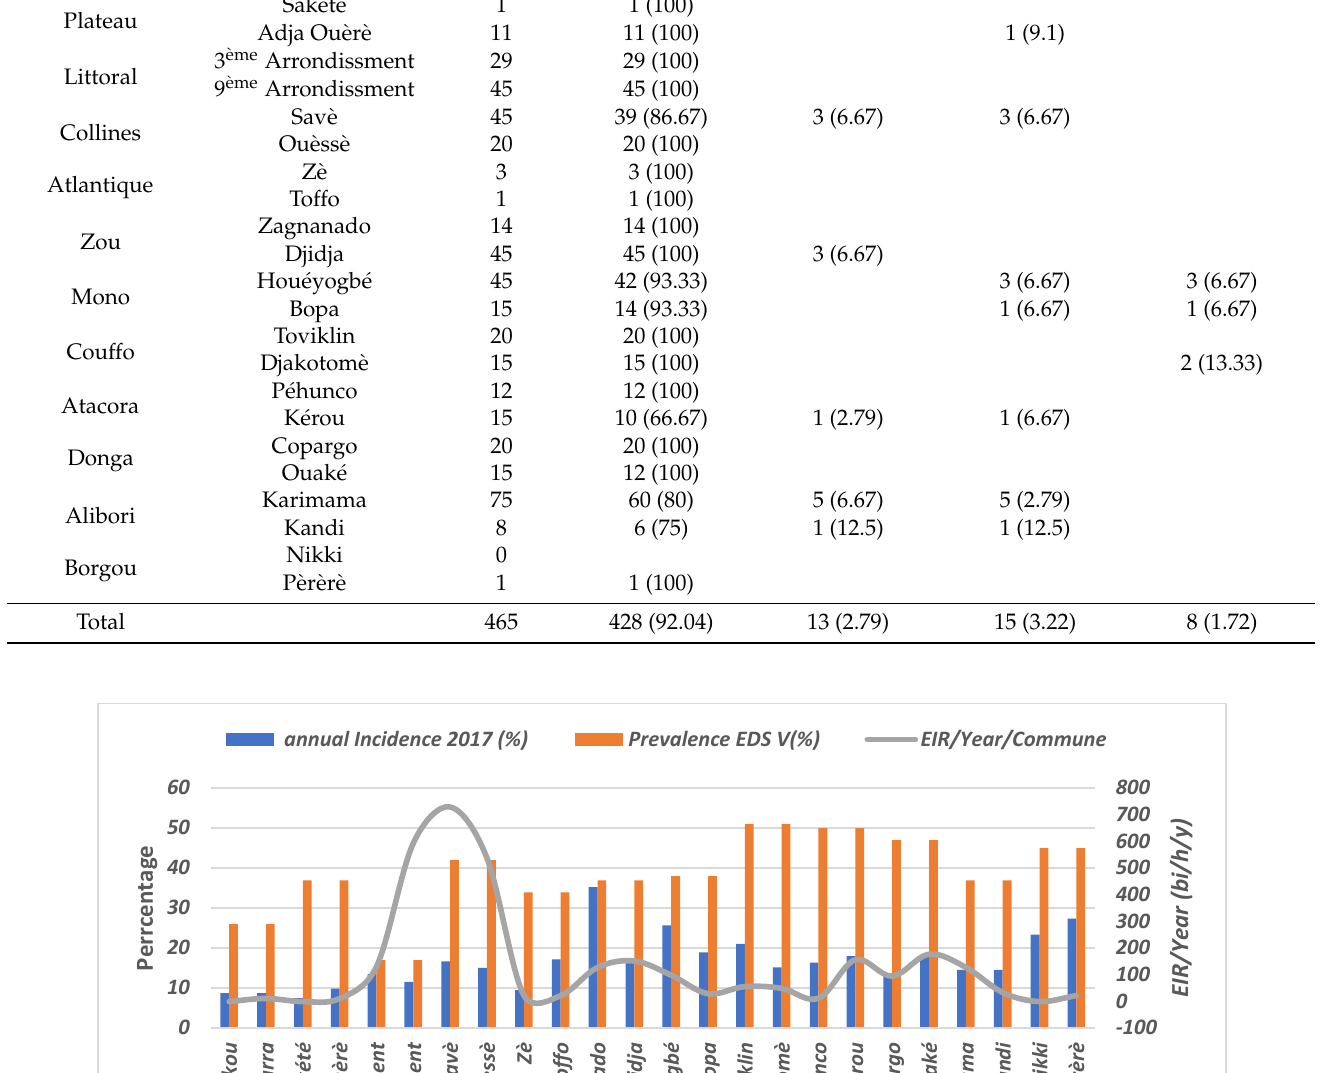
Figure 6. EIR, prevalence and incidence of malaria in different communes. Correlation tests between the EIR and malaria incidence and prevalence were not significant. Communes with high levels of entomological transmission did not show significant associations with incidence and prevalence rates.